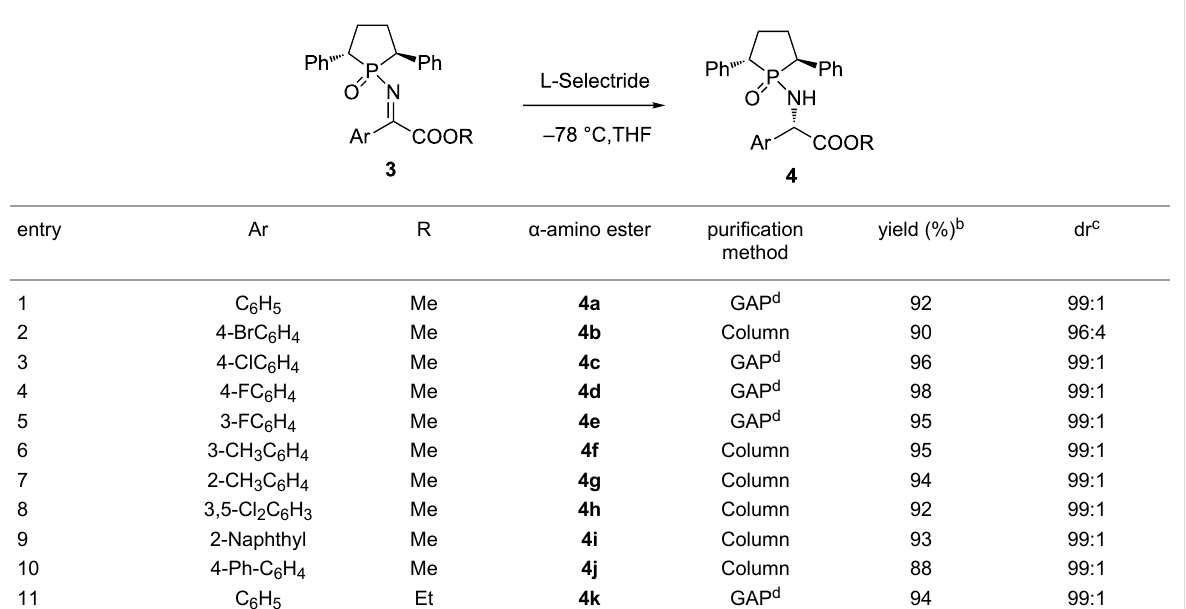
Table 4: Scope of novel phophinyl substituted α -amino esters. a